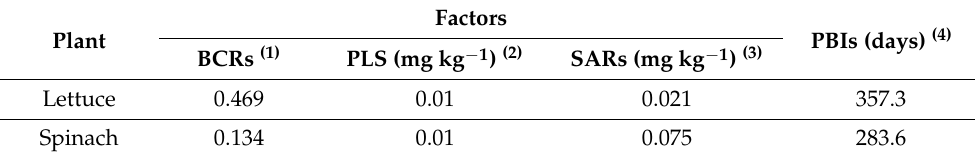
Table 6. Plant-back intervals (PBIs) of imicyafos for lettuce and spinach in greenhouse.